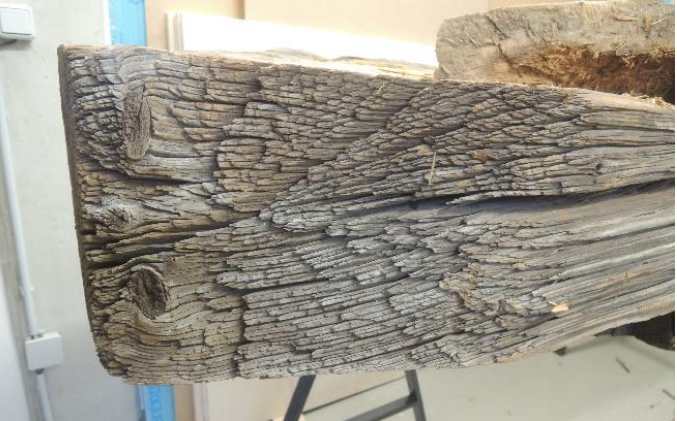
Figure 15. Detail of the damaged beam end before the repair, the end integrity ensured by the knot near the drying check.